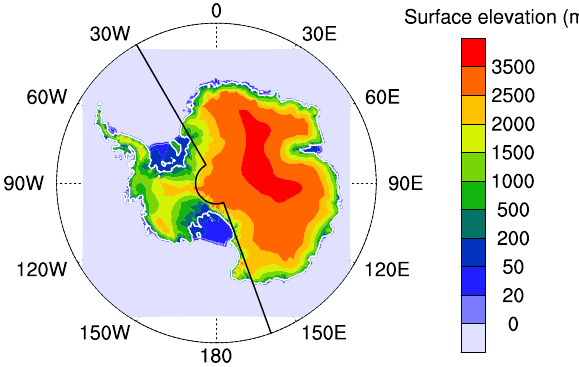
Figure 1. The PD surface elevation, used as an initial configuration 120ka. The white line indicates the grounding line and the black line separates the WAIS from the EAIS. The light blue box shows the ANICE model domain.